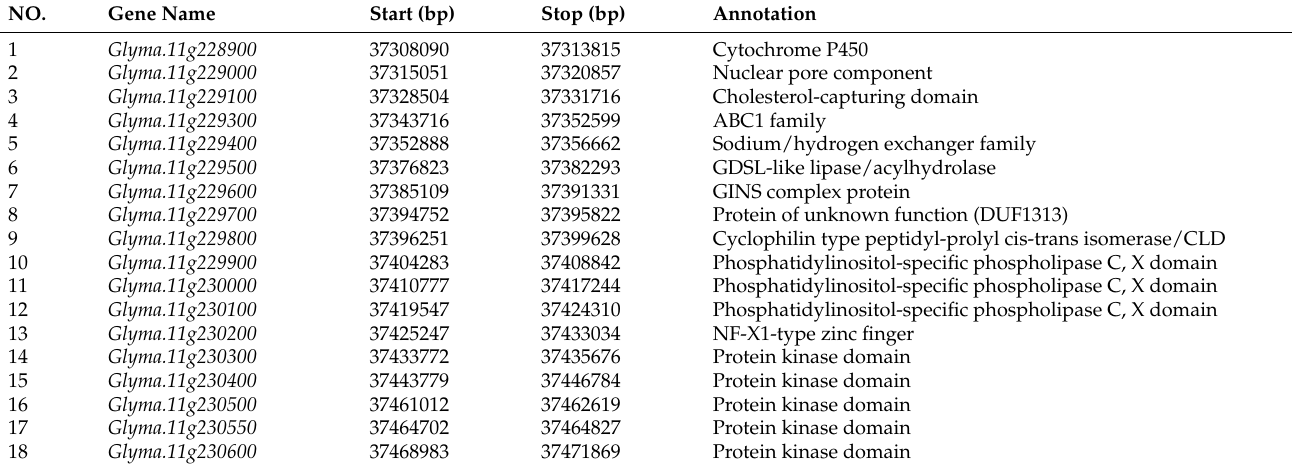
Table 3. Functional annotation of candidate genes in the spwp2 mapping interval.